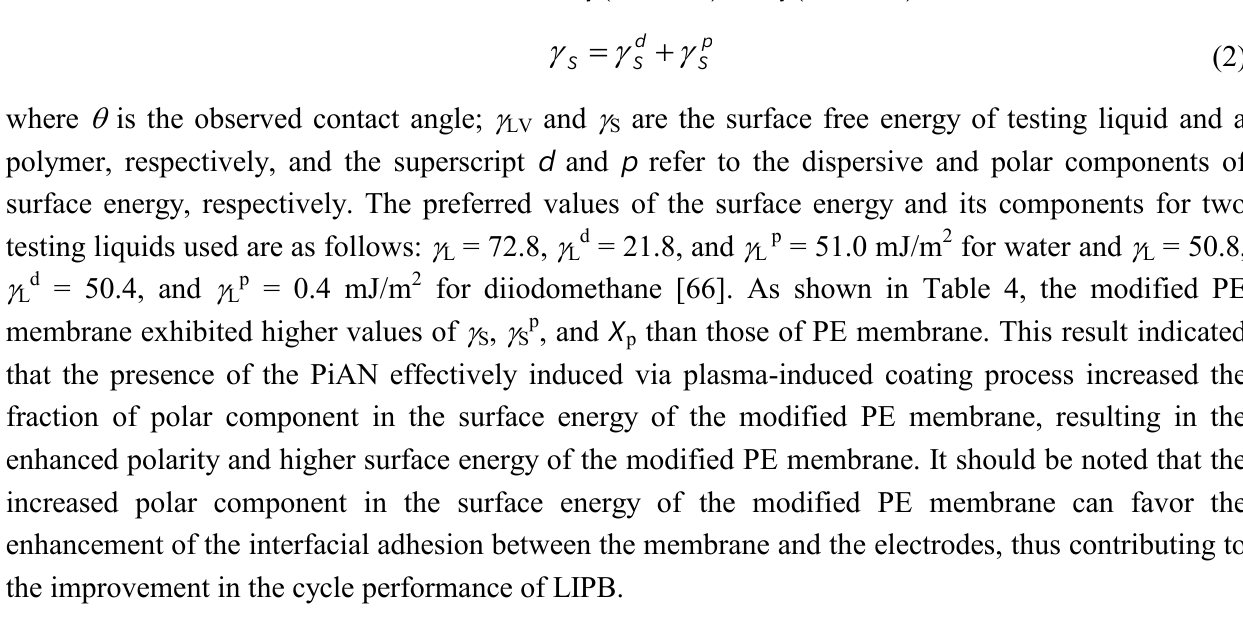
Table 4. The surface energy and polarity of PE and the modified PE membranes. Reproduced with permission from Reference [58]. © 2009 Elsevier